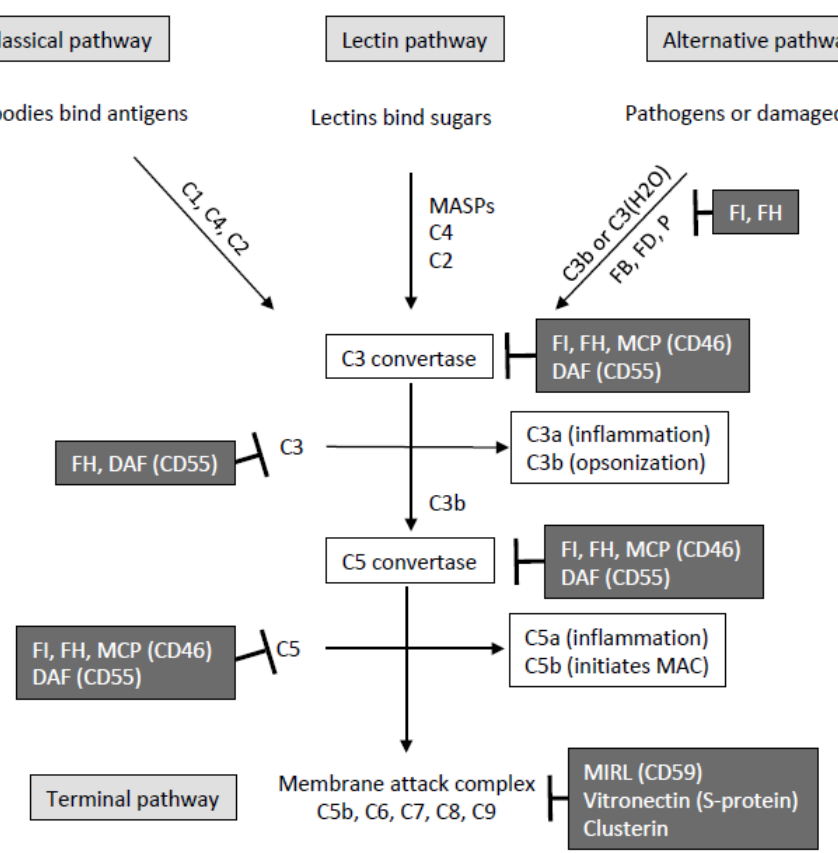
Figure 1. Complement system. There are three activation pathways in the complement system: classical, lectin, and alternative. All three pathways lead to the formation of C3 and C5 convertases, which rapidly amplify the complement response. In addition to the processes described above, several complement regulatory proteins are able to inhibit complement by inactivation of C3 and C5, and C3 and C5 convertases, or by preventing successful formation of the membrane attack complex. DAF: decay-accelerating factor or CD55; FB: factor B; FD: factor D; FH: factor H; FI: factor I; MASPs: MASP: MBL-associated serine proteases; MCP: membrane cofactor protein or CD46; MIRL: membrane inhibitor of reactive lysis or CD59; P: properdin.